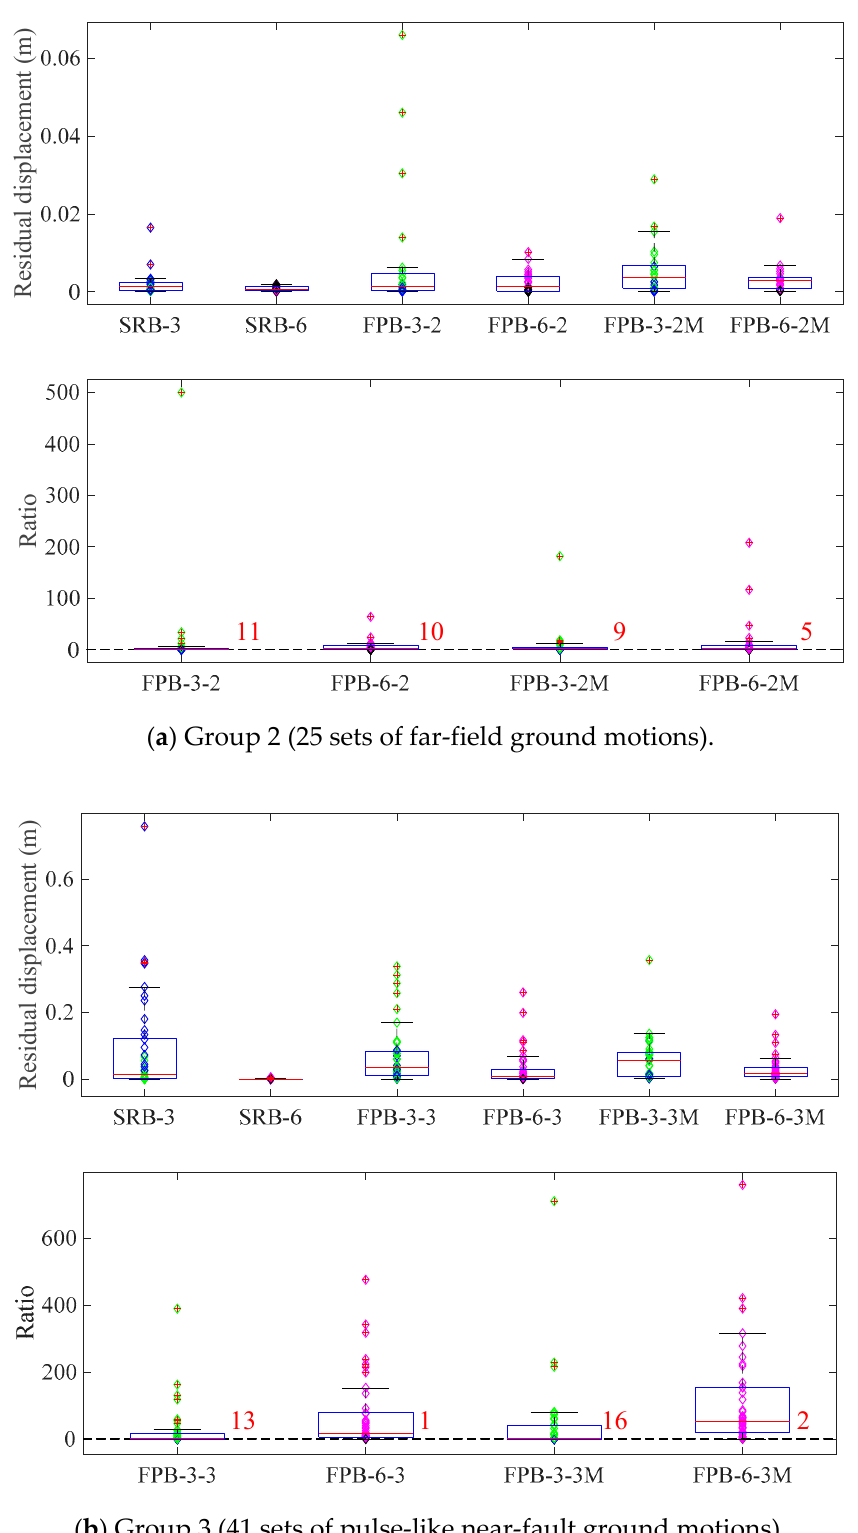
Figure 14. Comparisons of residual displacement responses of SRBs and FPBs subjected to different ground motions.